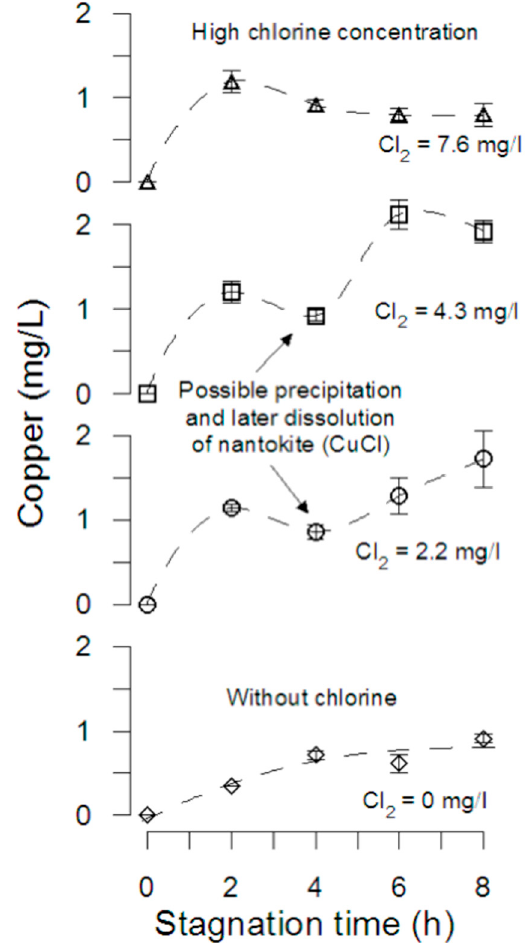
Figure 2. Copper release during stagnation. Pipe tests with different initial concentrations of chlorine. The error bars represent the standard deviation of the measurement (n = 2). Initial DO was 7.45 ± 0.12 mg/L.